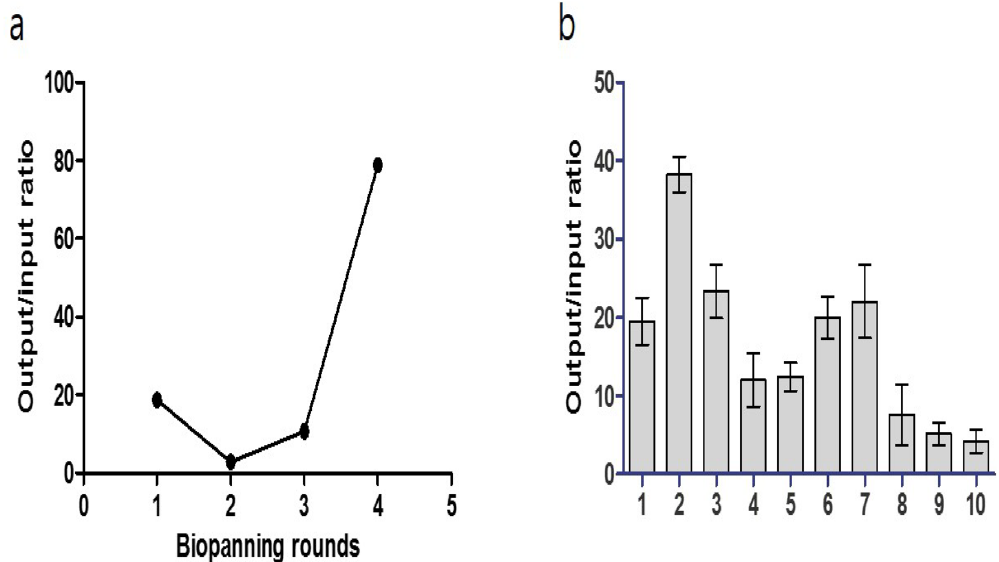
Figure 2. Phage selection of hydroxyapatite binding peptides from a randomized 8-mer peptide phage library. ( a ) Ratio of output/input phages after one, two, three, and four rounds of selection against hydroxyapatite. ( b ) The ratio of the output/input phage of hydroxyapatite-specific positive clones after the fourth biopanning.